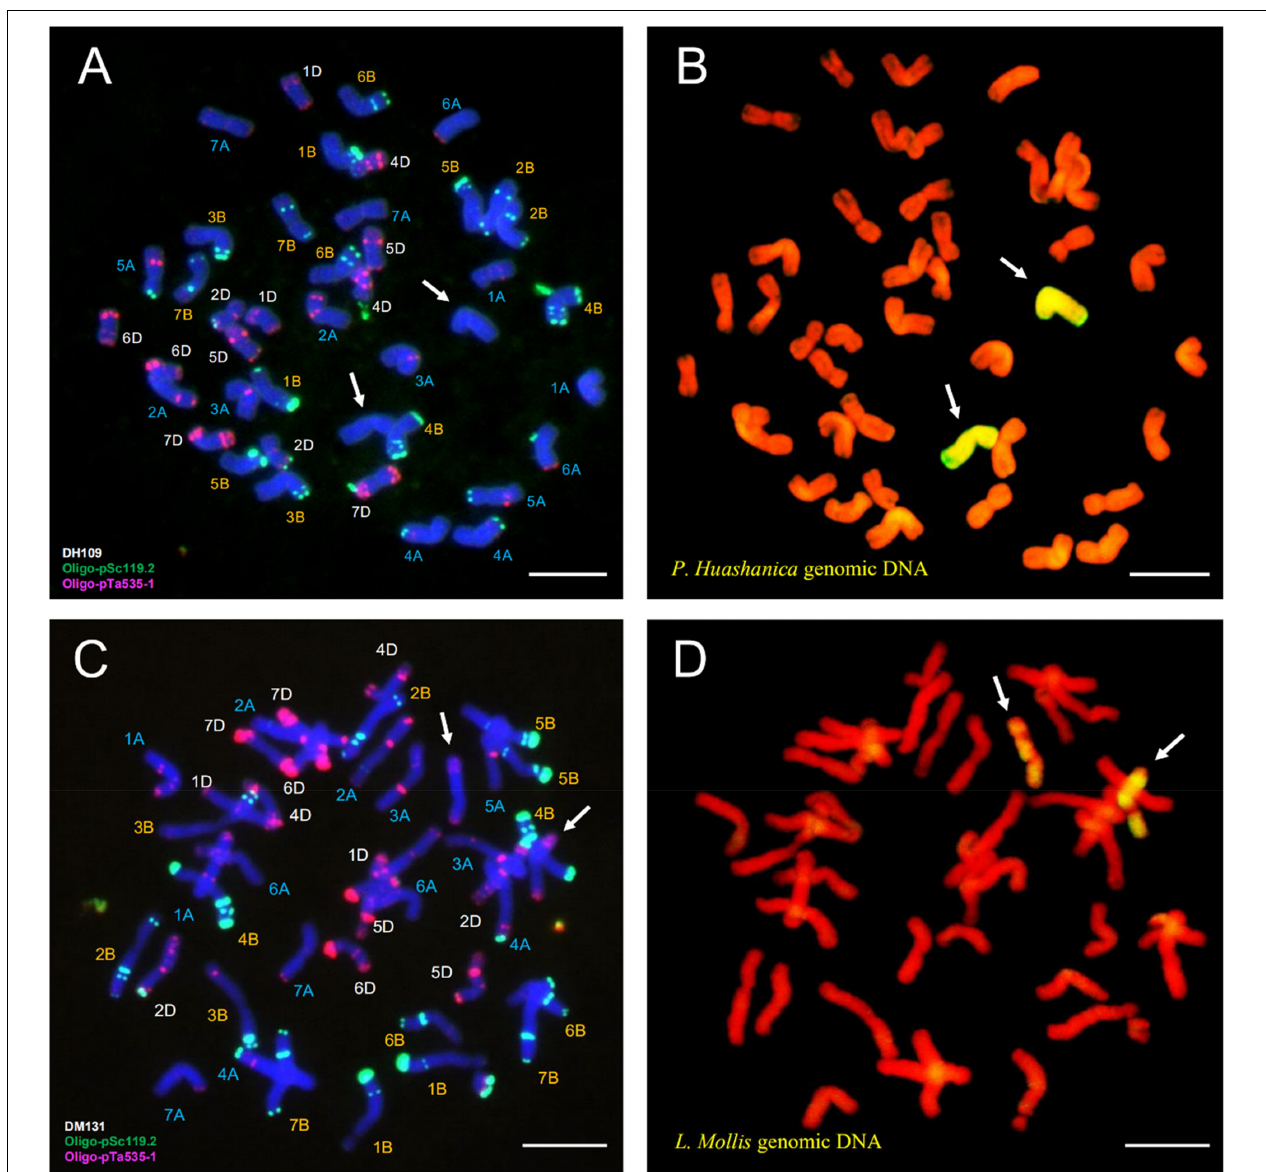
FIGURE 6 | Fluorescence in situ hybridization (FISH) and sequential GISH analysis of DH109 and DM131. Oligo-probes pSc119.2 and pTa535-1 were used during metaphase in RTCs to make the chromosomal composition visible. (A) FISH karyotype of DH109. (B) Two P. huashanica chromosomes with yellow–green signals were detected by sequential GISH at the same slide. (C) FISH karyotype of DM131. (D) Two L. mollis chromosomes with yellow–green signals were detected by sequential GISH at the same slide. Chromosomes were counterstained with DAPI (blue) in FISH and PI (red) in GISH. The arrows indicate the introduced alien chromosomes in the two derived lines. Scale bar, 10 µ